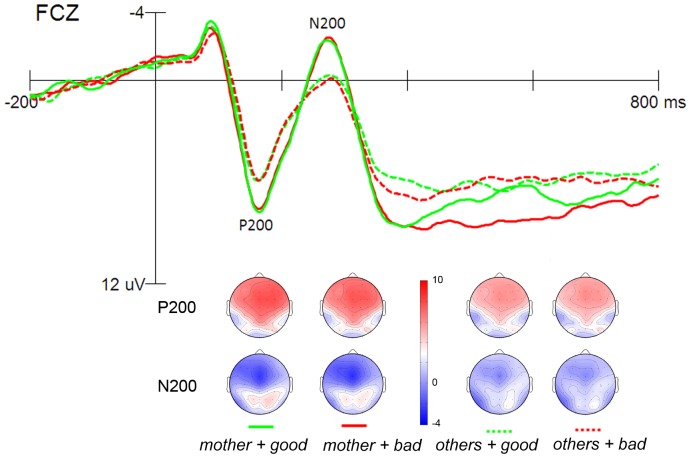
Grand averaged ERPs for target category words.The scalp topographies at peak latency for P200 and N200 of each condition are presented beneath.